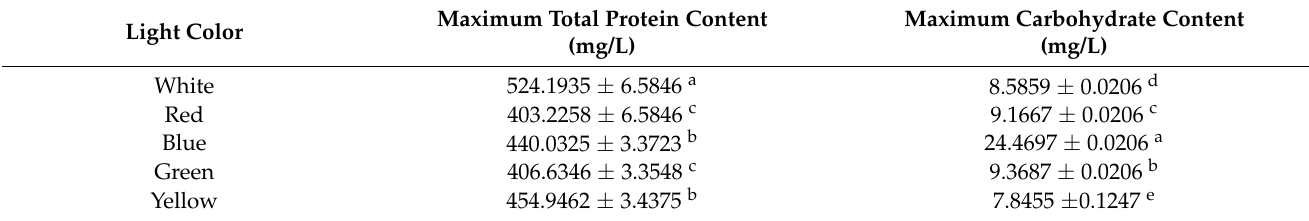
Table 2. Protein and carbohydrate content in I. zhangjiangensis cultured under different colored